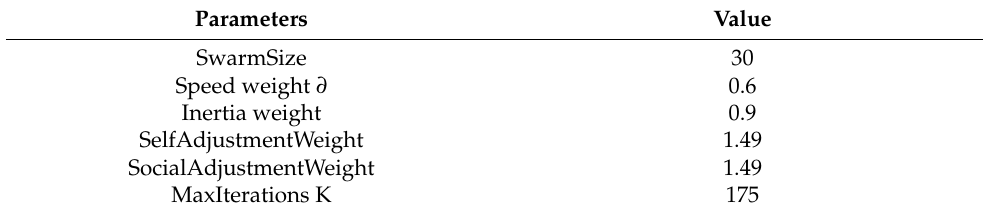
Table 4. The initial values of the algorithm parameters.